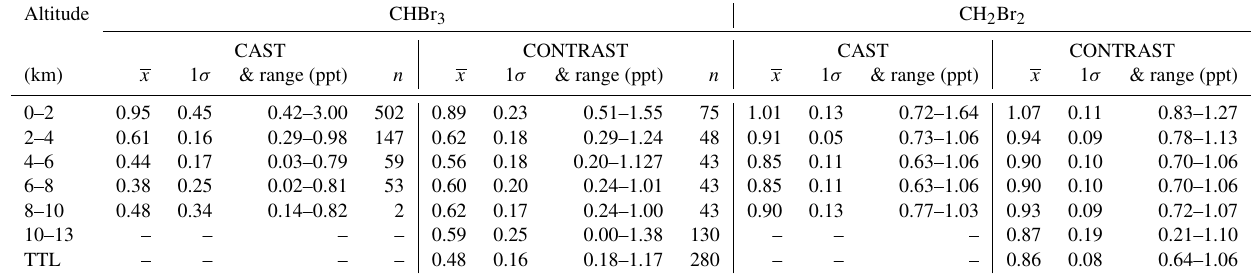
Table 1. Mean measurement statistics for CHBr 3 and CH 2 Br 2 mole fraction data as a function of altitude for CAST and CONTRAST aircraft campaigns. x , σ , and n denote the mean value, the standard deviation, and the number of data points used to determine the statistics. Altitude CHBr 3